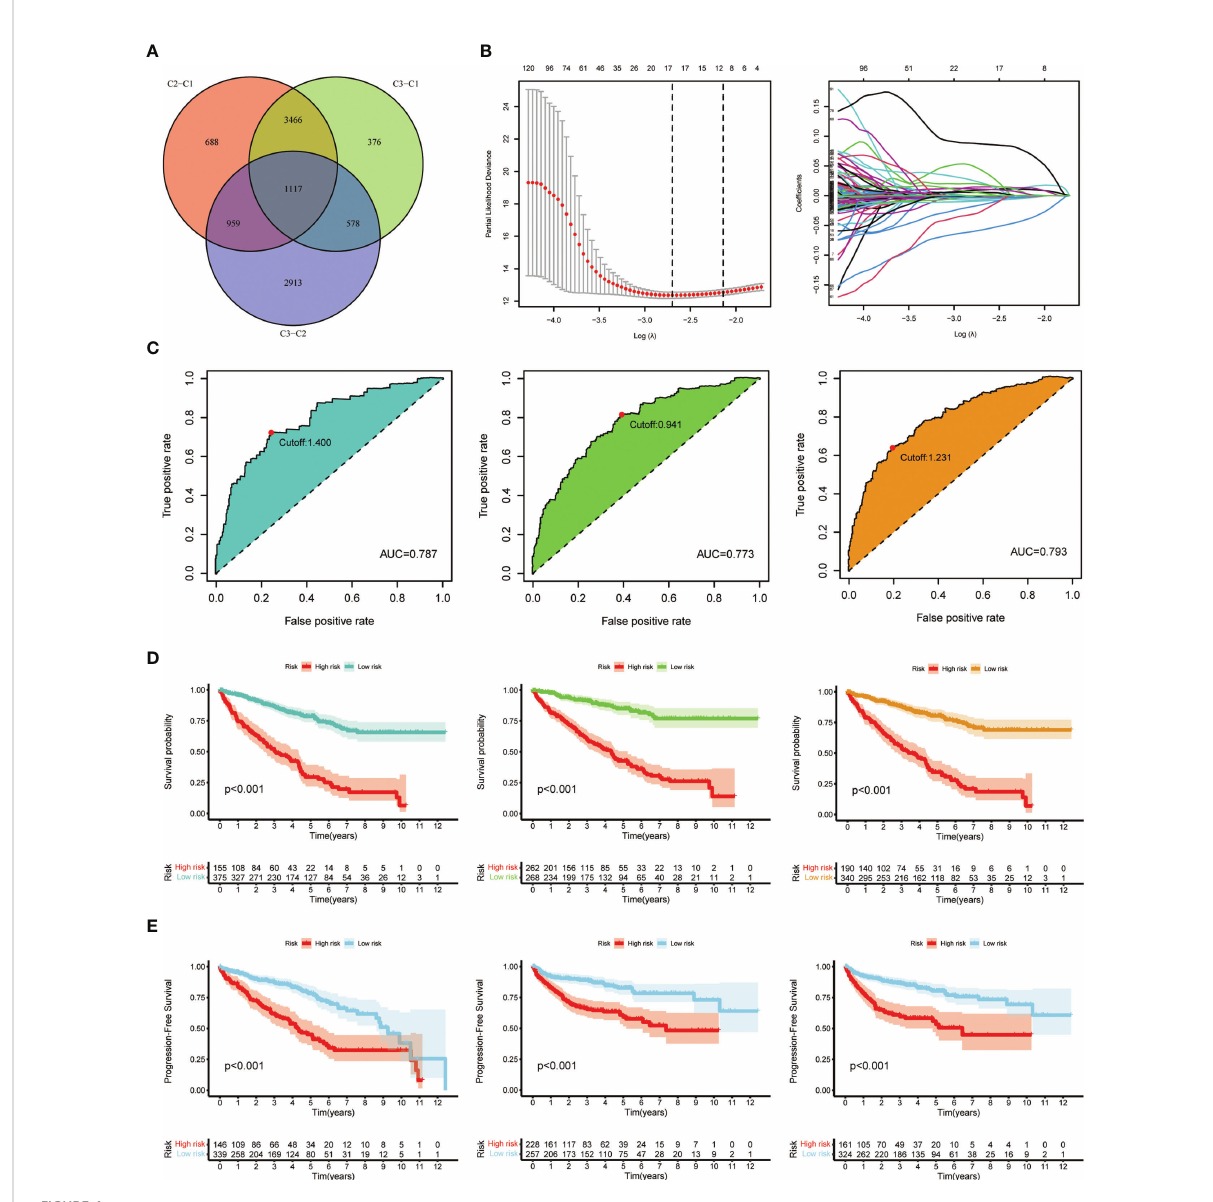
FIGURE 4 Generation and validation of the prognostic model. (A) Venn diagram of the DEGs via pairwise comparison among three subgroups. (B) LASSO regression analysis used to construct the prognostic model. (C) ROC curves for the predictive risk model of 1 year (left), 3 years (middle), and 5 years (right). (D) Overall survival analysis at the cutoff values: 1.400 (left), 0.941 (middle), and 1.231 (right). (E) Progression-free survival analysis at the cutoff values: 1.400 (left), 0.941 (middle), and 1.231